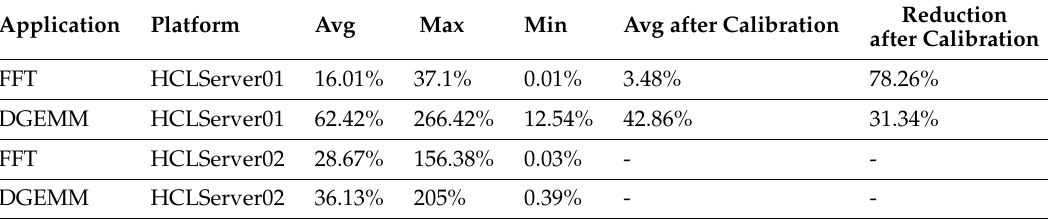
Table A4. Percentage error of dynamic energy consumption with RAPL and HCLWattsUp on HCLServer01 and HCLServer02. ’-’ denotes that calibration does not improve the difference.